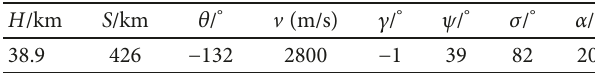
Table 2: Initial state of missile.